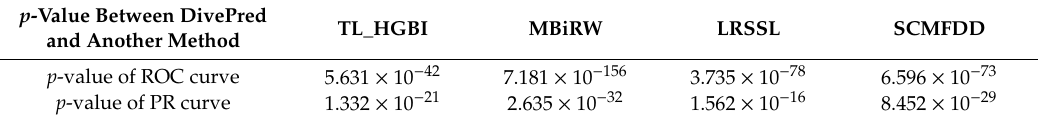
Table 3. Results of Wilcoxon test on DivePred and four other contrast methods for 763 drugs. p -Value Between DivePred and Another Method